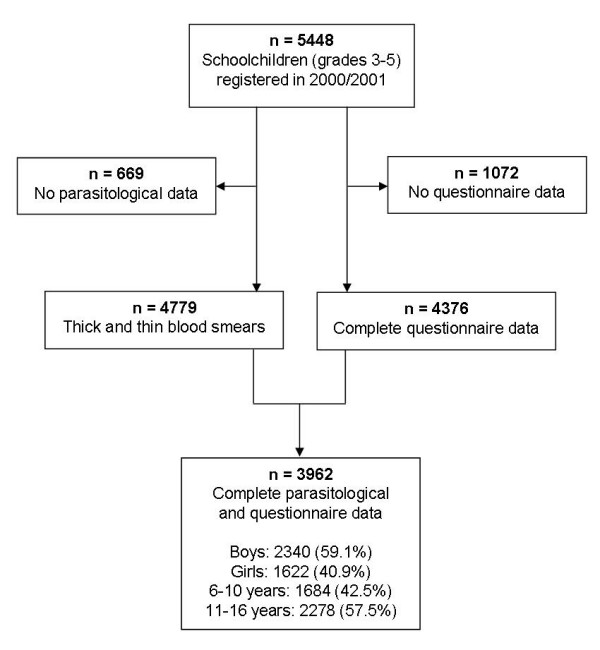
Study profile and compliance.